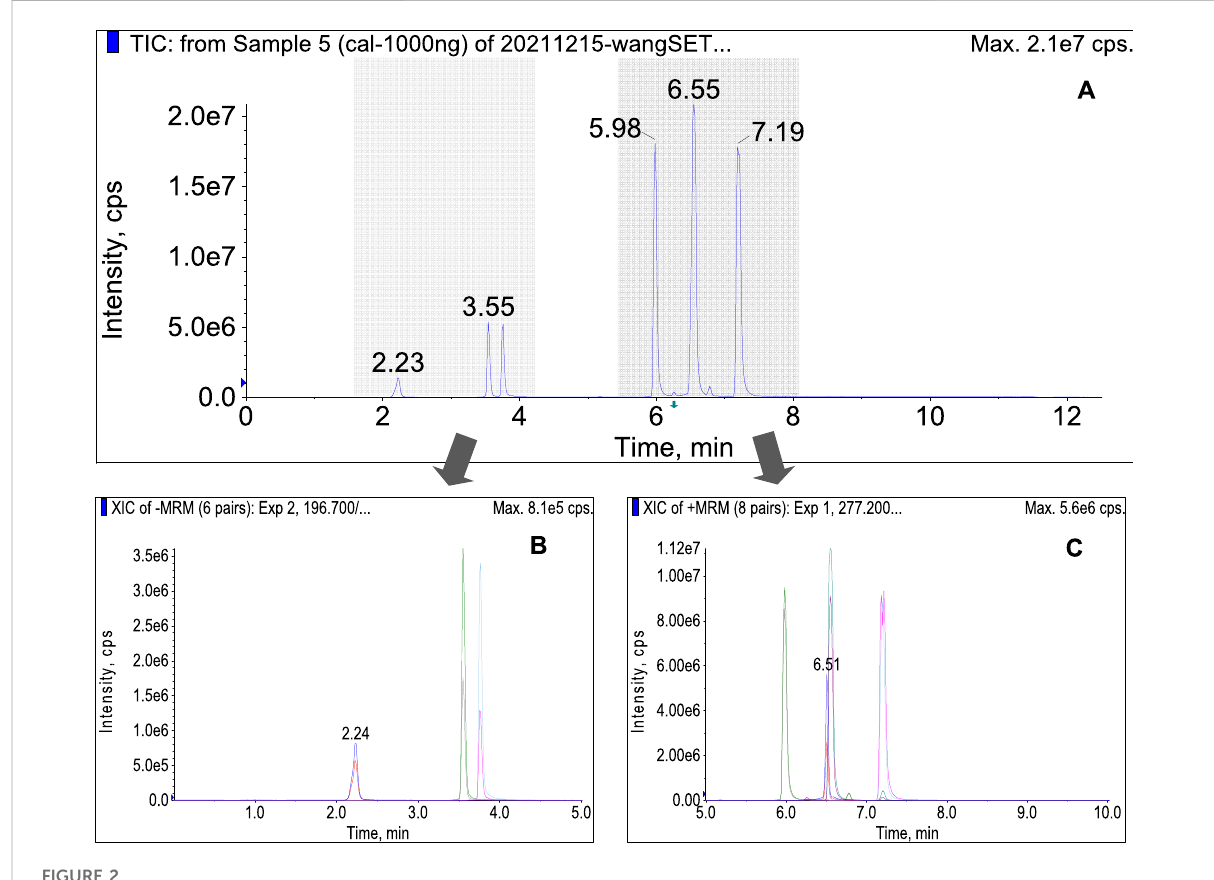
FIGURE 2 (A) total current chromatogram of the seven bioactive compounds under the optimized conditions in polarity switching mode, (B) MRM chromatogram of salvianate A, rosmarinic acid, and salvianolic acid in negative ion mode, (C) cryptotanshinone, dihydrotanshinone, tanshinone IIA, and tanshinone I in positive ion